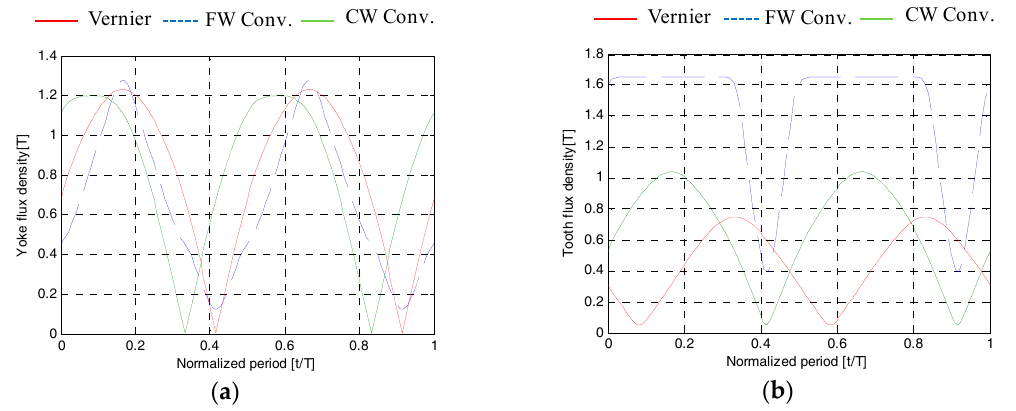
Figure 8. Simulation results of flux densities. ( a ) Yoke flux density; ( b ) Tooth flux density.